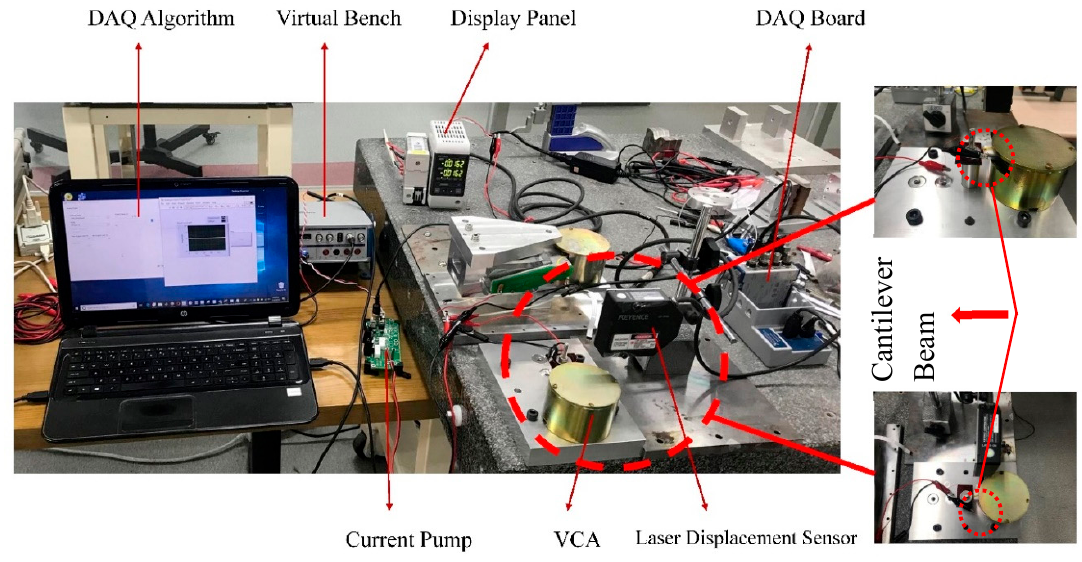
Figure 12. Experimental setup.